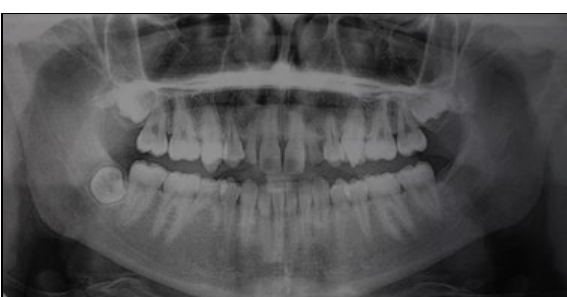
Figure 3. Pretreatment panoramic radiograph.